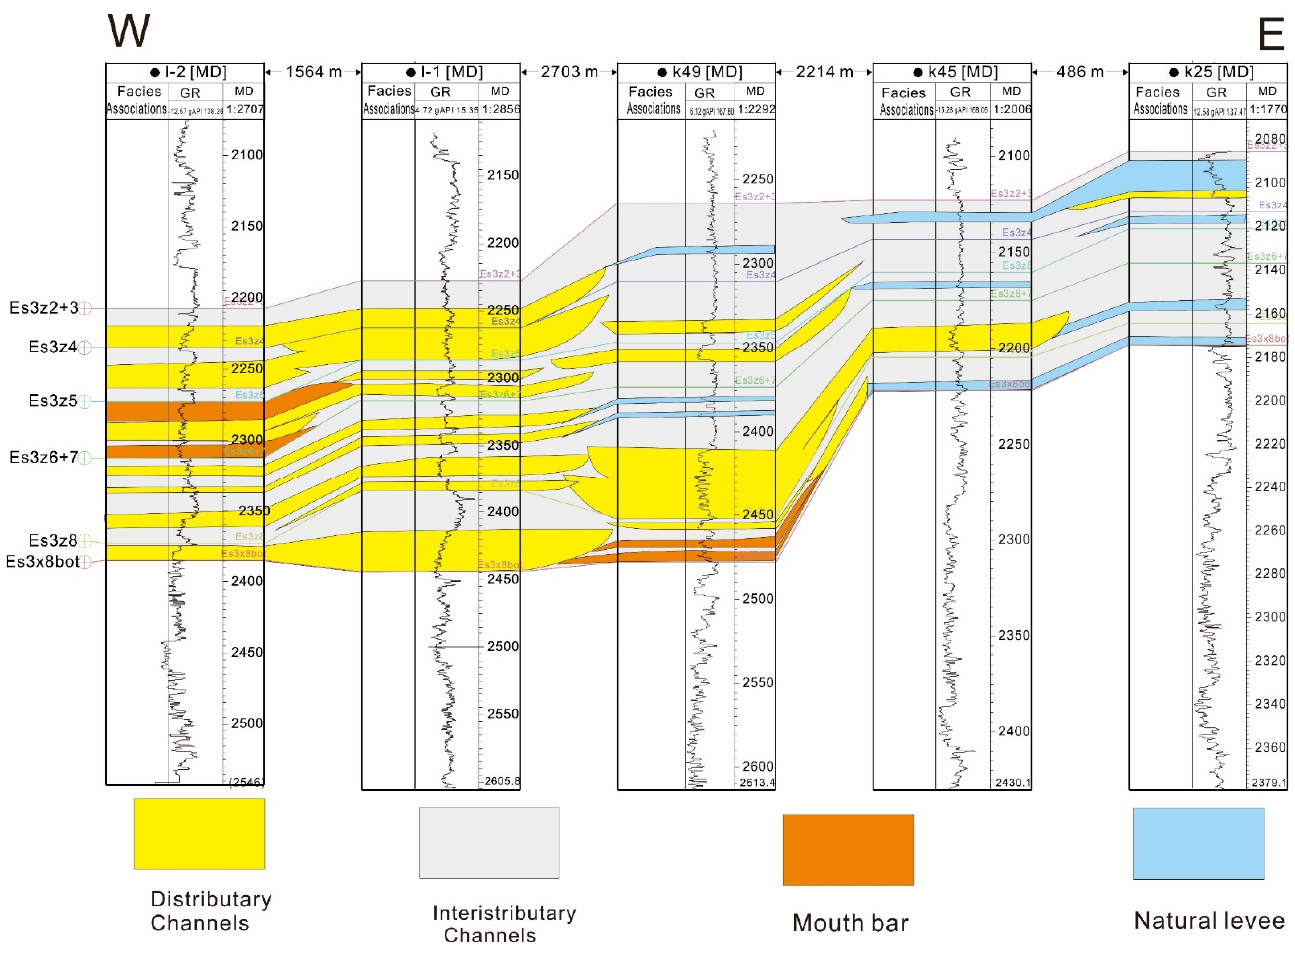
Figure 15. Cross section profile 5 of facies associations in five sandstones groups. showing facies to facies correlations from east to west direction.